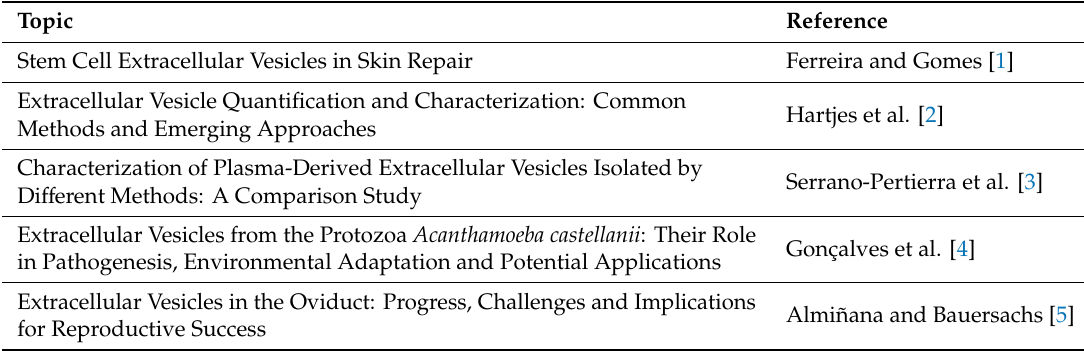
Table 1. Publications in special